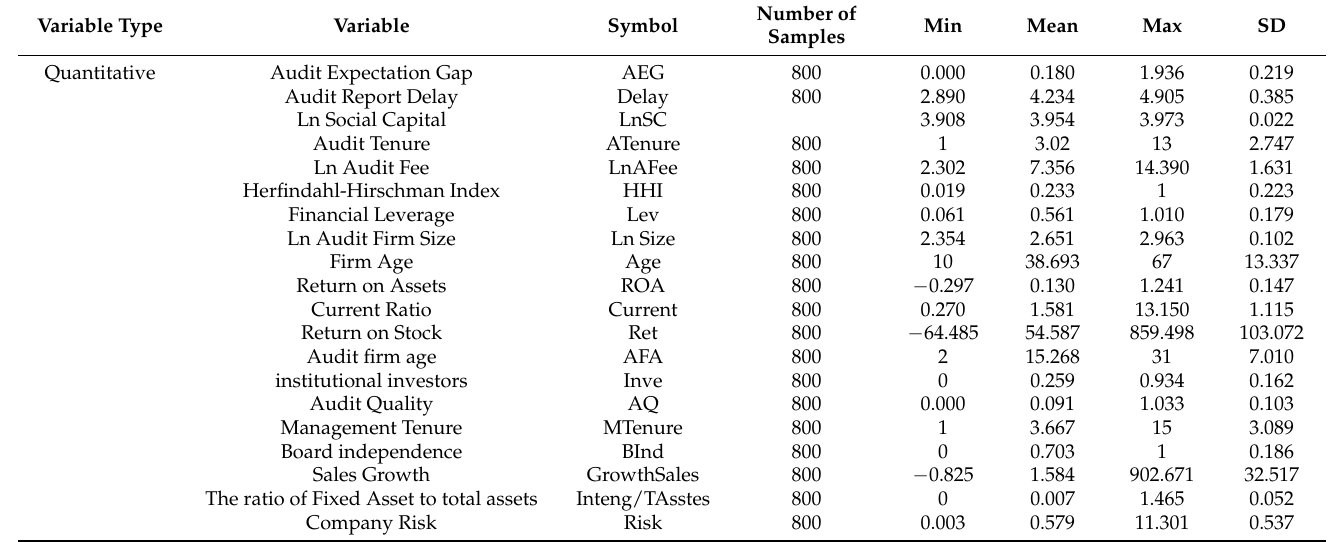
Table 2. The Descriptive statistic of